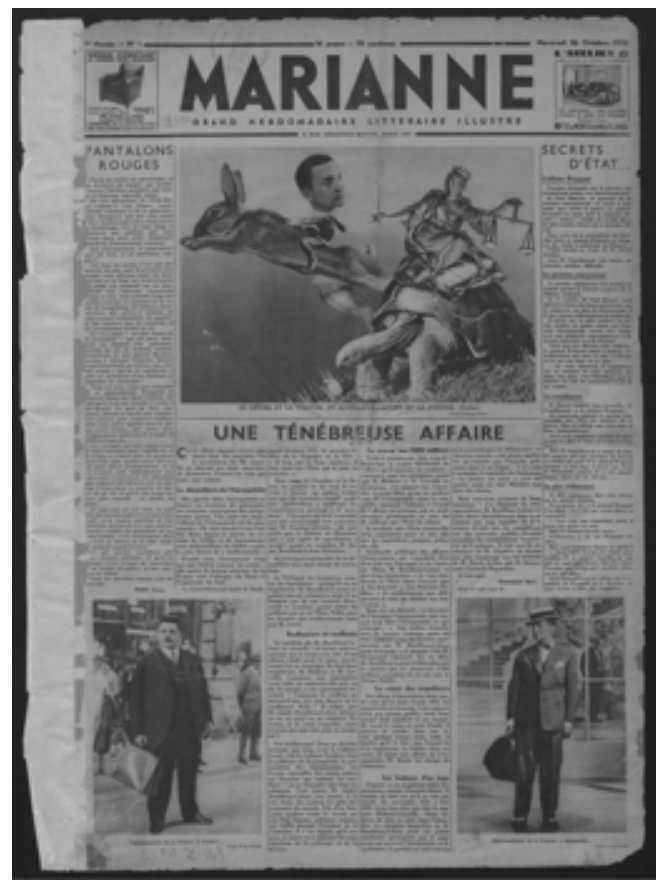
Fig. 3 Une de Marianne , no. 1 (26 octobre 1932), source gallica.bnf.fr,